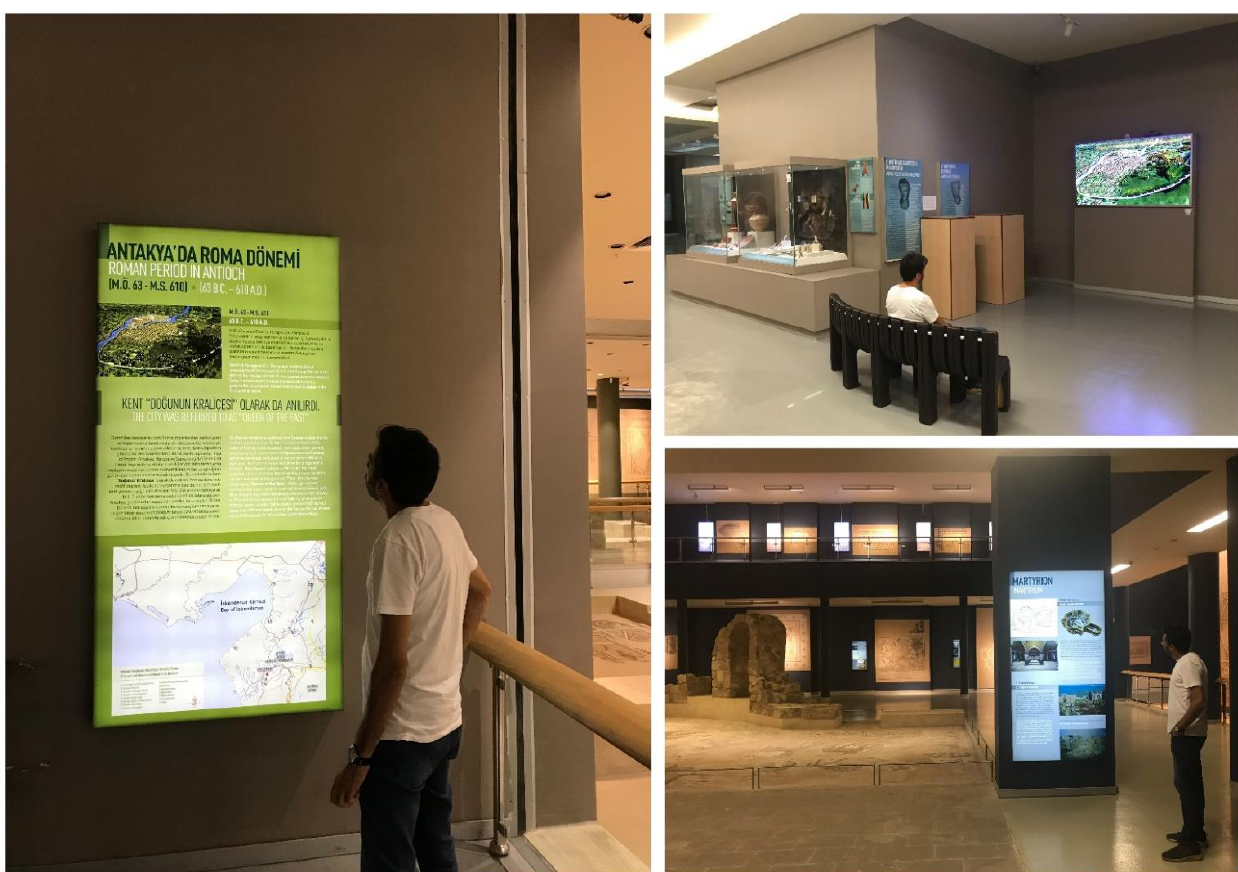
Figure 12. Three-dimensional Antioch images in Hatay Archeology Museum.